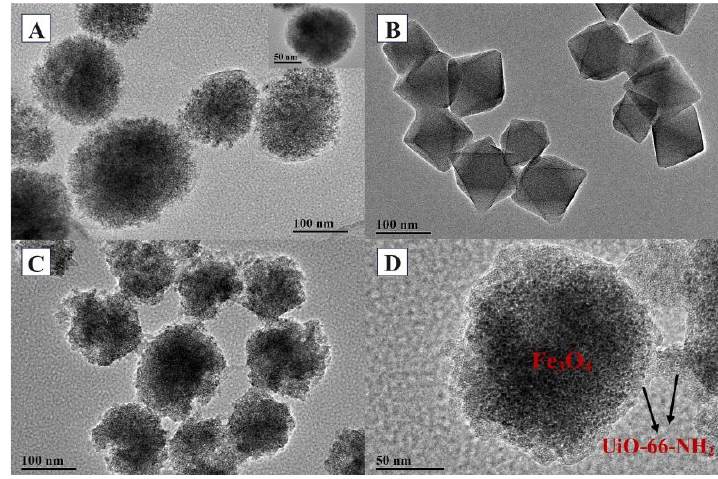
Figure 4. TEM images of Fe 3 O 4 -COOH ( A ), UiO-66-NH 2 ( B ), Fe 3 O 4 -COOH@UiO-66-NH 2 ( C , D ).